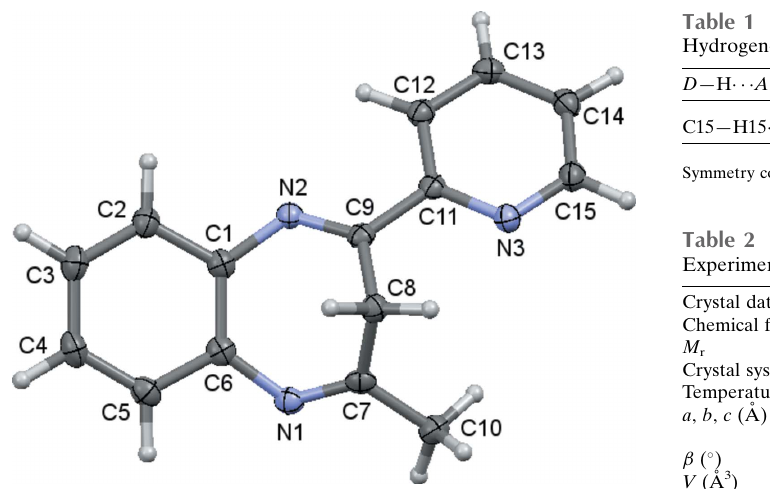
Figure 1 The molecular structure of the title molecule with the labelling scheme and 50% probability ellipsoids.